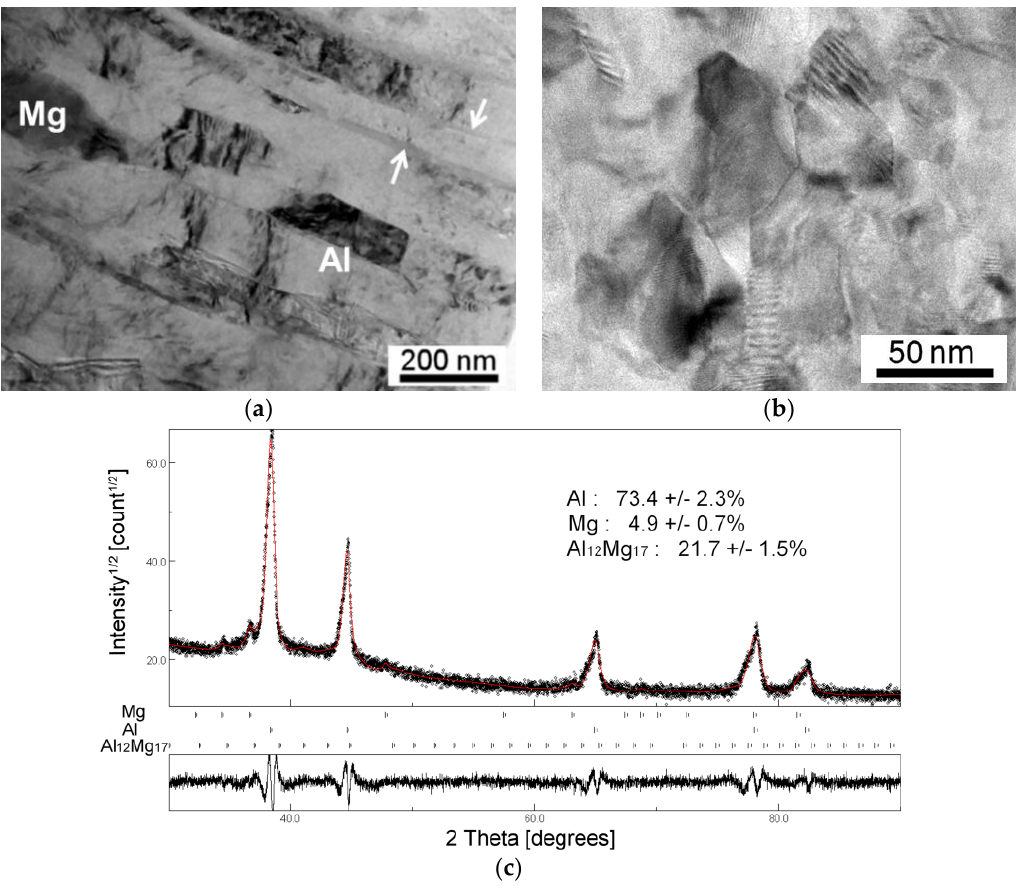
Figure 2. TEM bright-field images taken at the Al-Mg disk edges after HPT for ( a ) five turns and ( b ) 10 turns and ( c ) the XRD profile with the MAUD estimation for the disk edge after 10 HPT turns [34]. The TEM micrographs taken at the peripheral region after HPT for 20 turns are shown